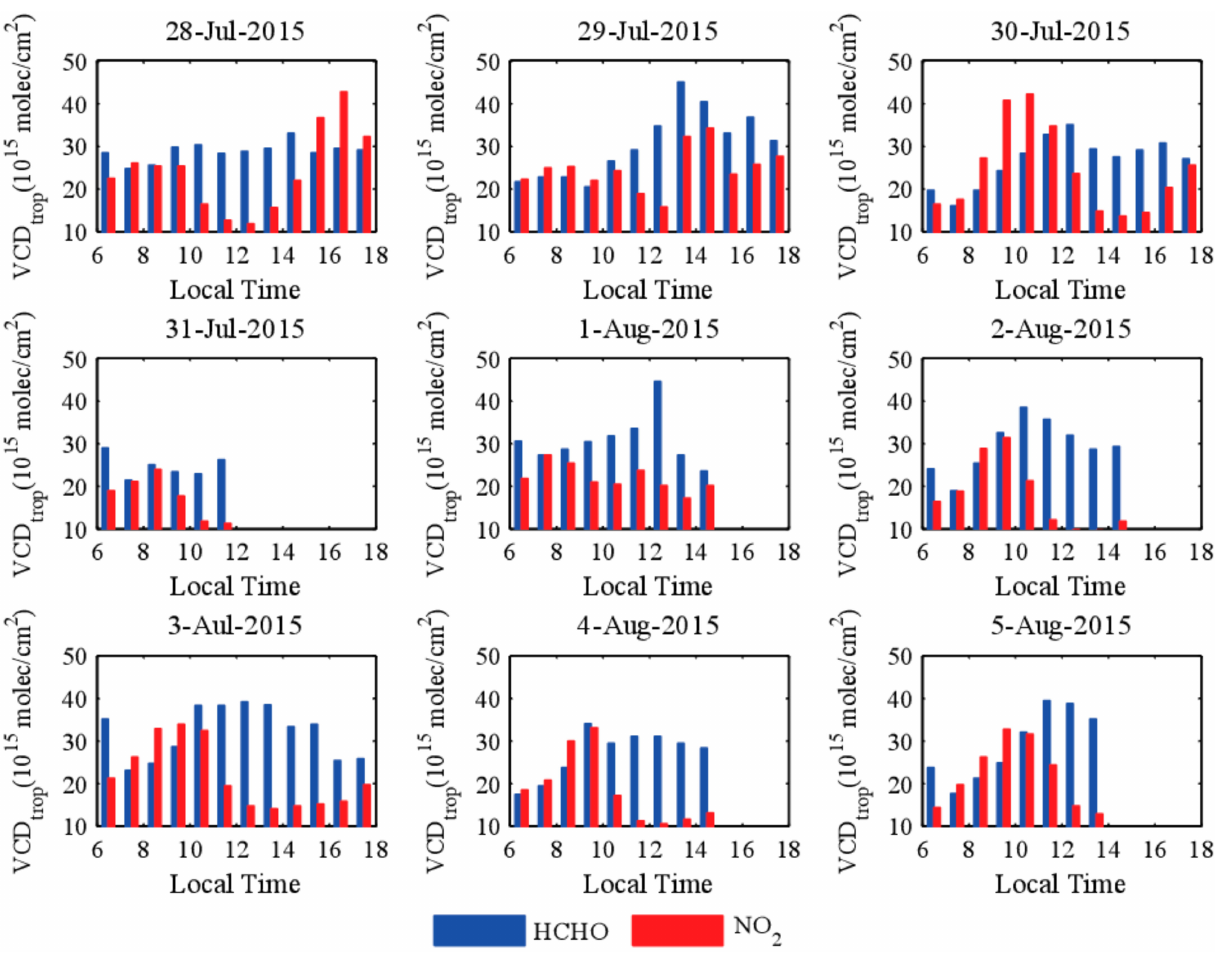
Figure 9. Time series of tropospheric vertical column densities of NO 2 and HCHO retrieved from MAXDOAS measurement in Shanghai from 28 July to 5 August 2015(6:00~18:00